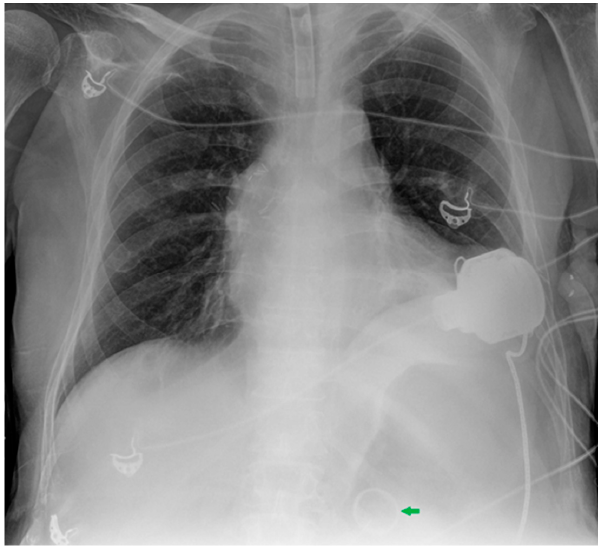
Figure 38. PA ( a ) and LL ( b ) CXR of a patient with bilateral ureteral stents (red arrows).